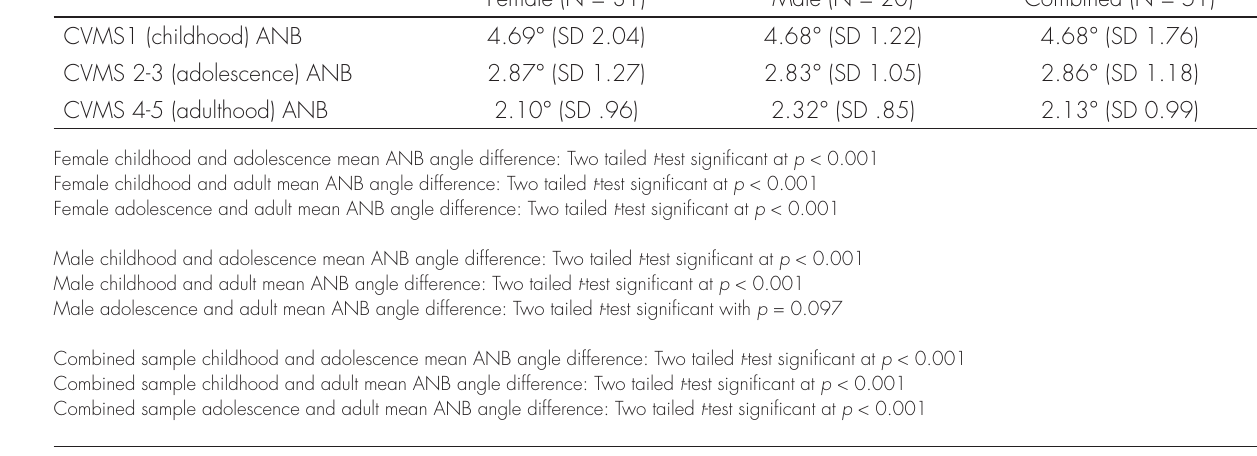
Table II. Mean male and female ANB angles in Class I subjects at childhood, adolescence and adulthood, and P values for two tailed t -test comparing mean ANB angles for each age category within each gender.